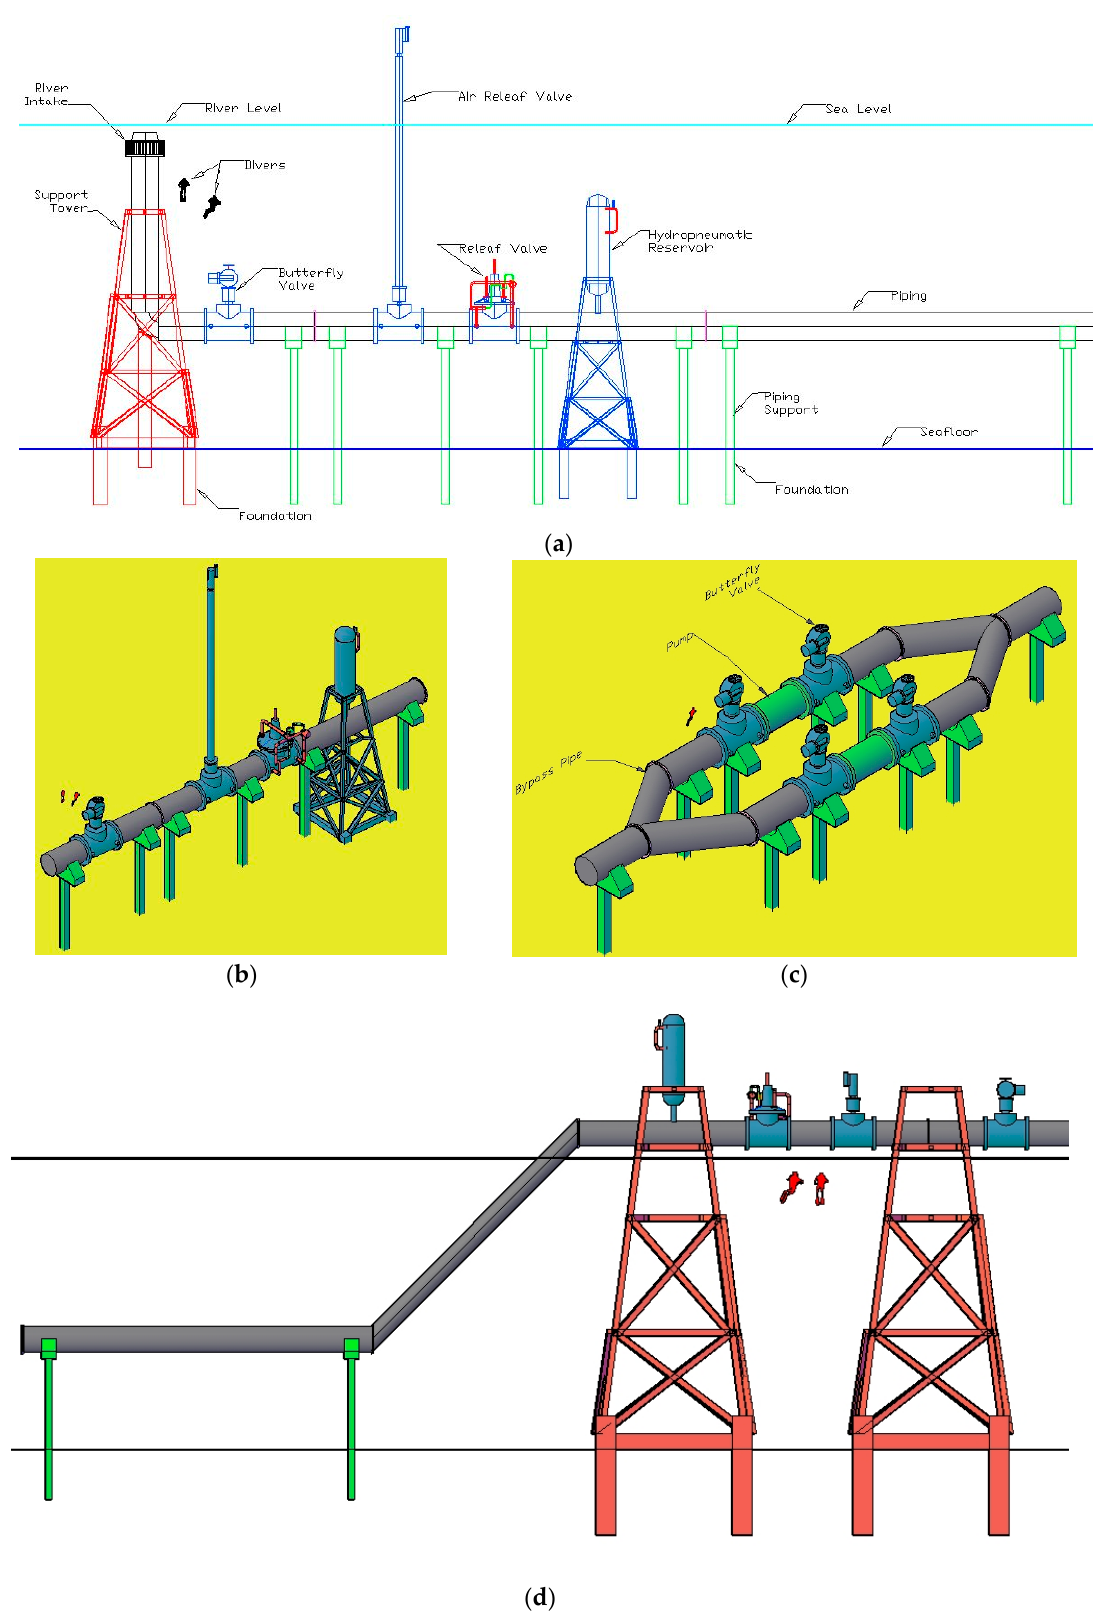
Figure 16. Schematic diagram of the underwater pipeline to Fortaleza, Brazil; ( a ) Intake station; ( b ) Maneuver station; ( c ) Pumping station; and ( d ) Delivery station.